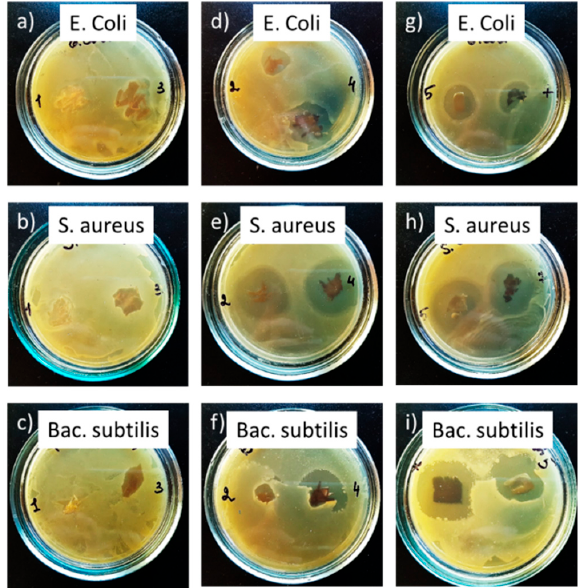
Figure 9. The antibacterial performance of ( a – c ) blank chitosan and chitosan/Ag NP composites prepared using the system with ( d – f ) liquid cathode and ( g – i ) liquid anode against Escherichia coli , Staphylococcus aureus , and Bacillus subtilis . Treatment time, 30 min. Incubation time, 24 h.